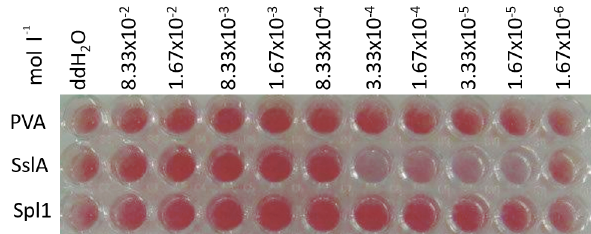
Figure 7. Schematic representation of the biofunctionalization of the SPR-chip and the sensor principle after addition of the analyte.